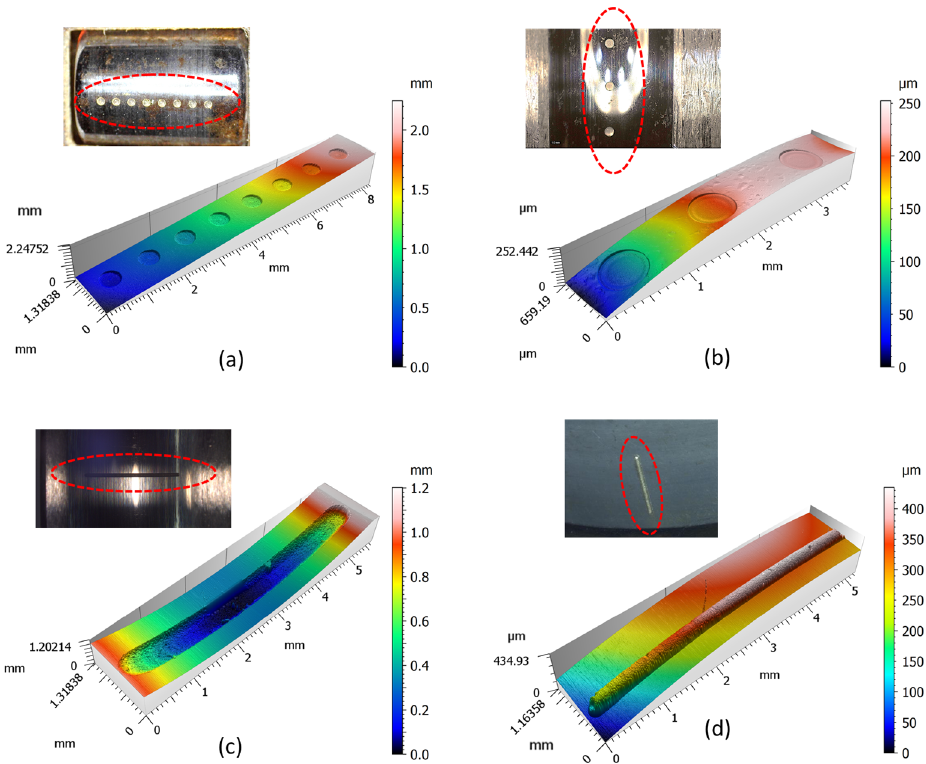
Figure 8. Uniformly distributed pittings ( a ) on a thrust ball element and ( b ) on a bearing inner raceway. Singular spalling ( c ) on a bearing inner raceway and ( d ) on a bearing outering (replica).